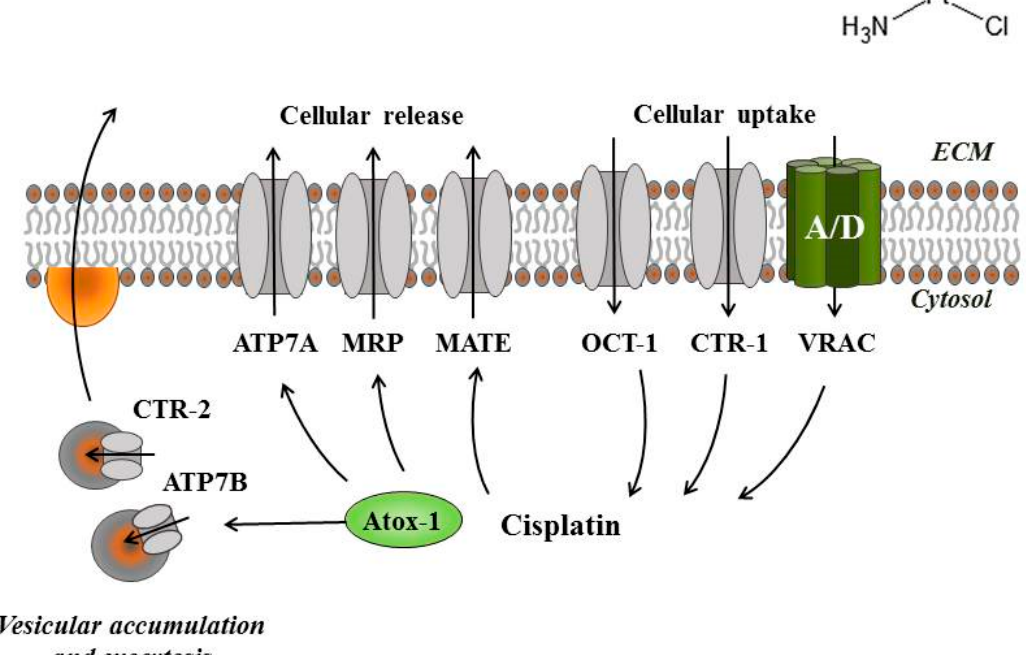
Figure 1. Cisplatin transporters involved in cisplatin accumulation. Cu transporters: CTR1, CTR2, ATP7A, and ATP7B. ABC transporters: MRP. Chaperone protein: Atox-1. Organic cation transporters: OCT1. Multidrug and toxin extrusion family members: MATE. Volume sensitive, LRRC8A/D-containing proteins: VRAC .